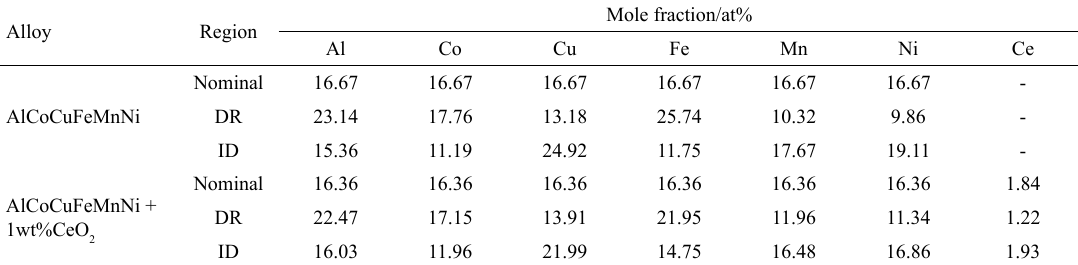
Figure 4. SEM images of AlCoCuFeMnNi alloy without (a, b) and with (c, d) 1wt% CeO Table 2. EDS analysis results of AlCoCuFeMnNi alloy without and with 1wt% CeO